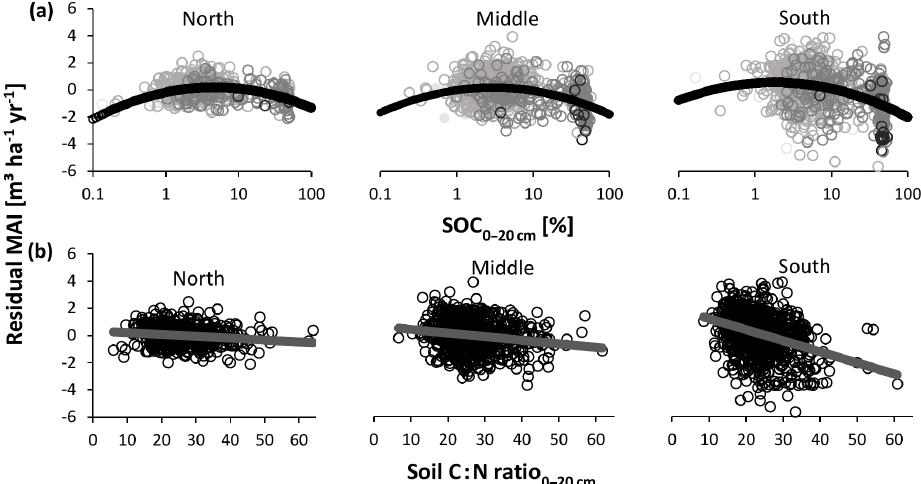
Figure 7. Relationship between normalized productivity following method 1 (residual mean annual increment – MAI); (a) log-transformed soil organic carbon concentration (SOC); (b) soil carbon-to-nitrogen (C:N) ratio at a depth of 0–20cm. Separate analyses were performed for northern, middle, and southern Sweden, as the SOC and C:N effects differed among regions. Point darkness in (a) represents soil moisture (darker: moister). Statistics corresponding to the panels are presented in Table 2. Note that the horizontal axis for SOC covers a broader range here than in Fig. 1, as SOC varied widely in the Swedish